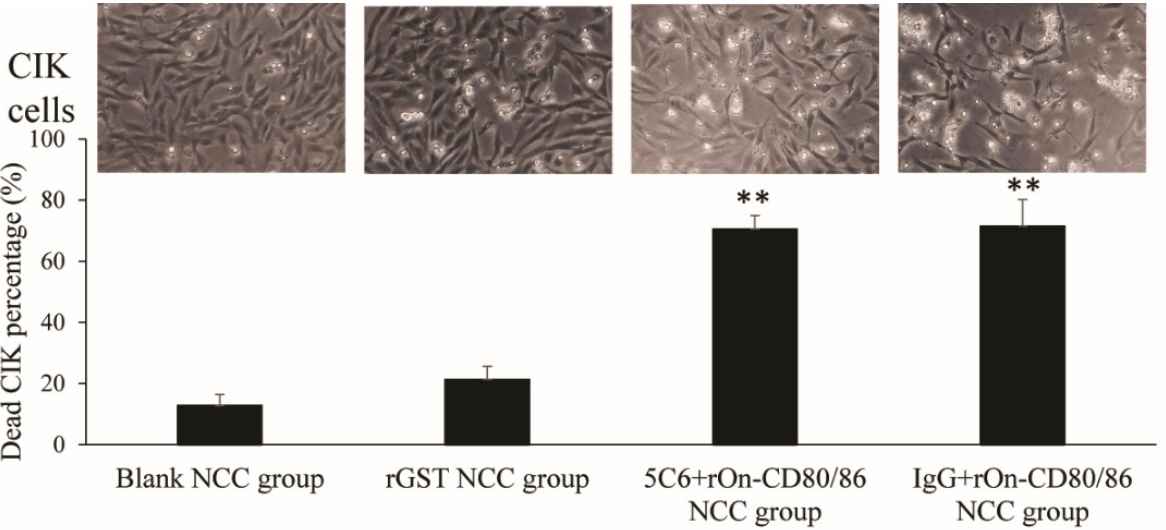
Figure 3. Killing activity of NCC on CIK. Photographs of CIK (upper) and corresponding dead cell percentage of CIK (lower). Data are shown as mean ± SE, and the significant difference was indicated by asterisks, **: p < 0.01.